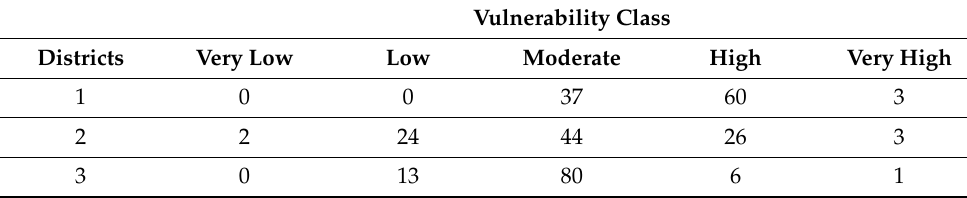
Table 5. The percentage of the area of different vulnerable classes for the 22 districts of Tehran. Vulnerability